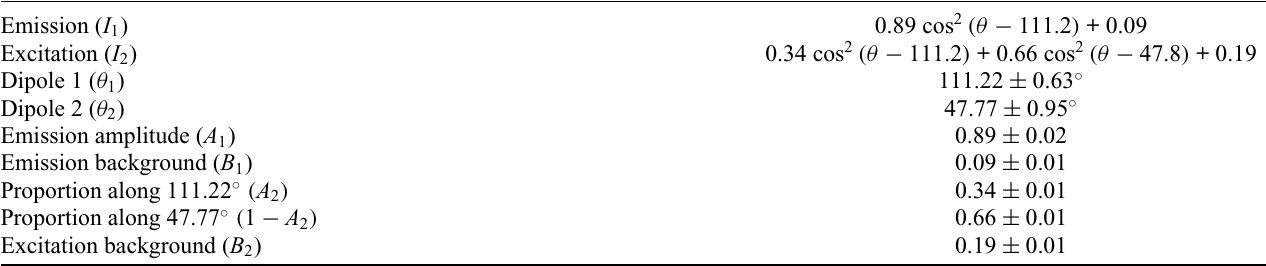
TABLE III. Result of simultaneous fit of QE C’s emission and excitation